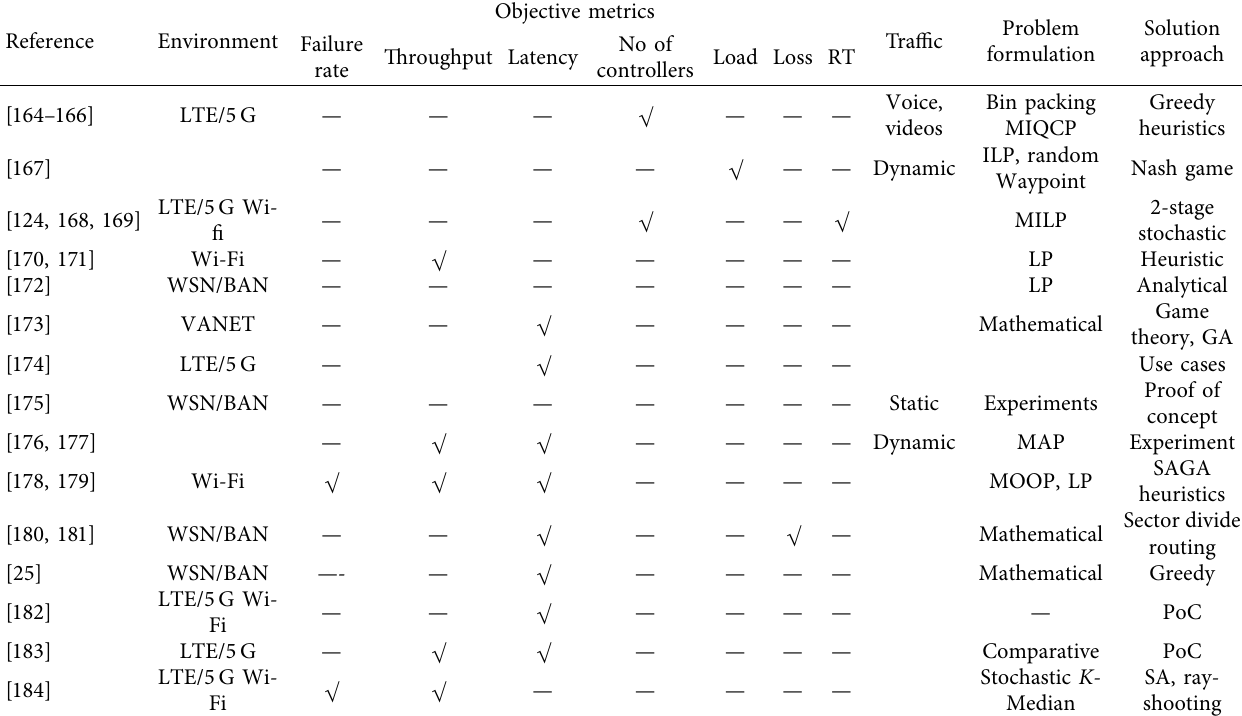
Table 9: Comparison of deployment environment aware controller